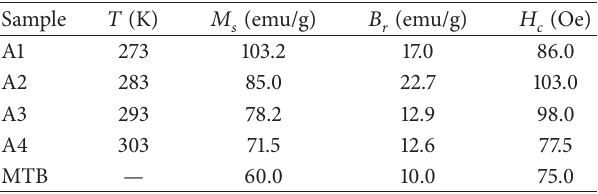
Table 2: Magnetic properties of magnetite samples (A1 to A4) prepared at different temperatures and their comparison with magnetite in (MTB)